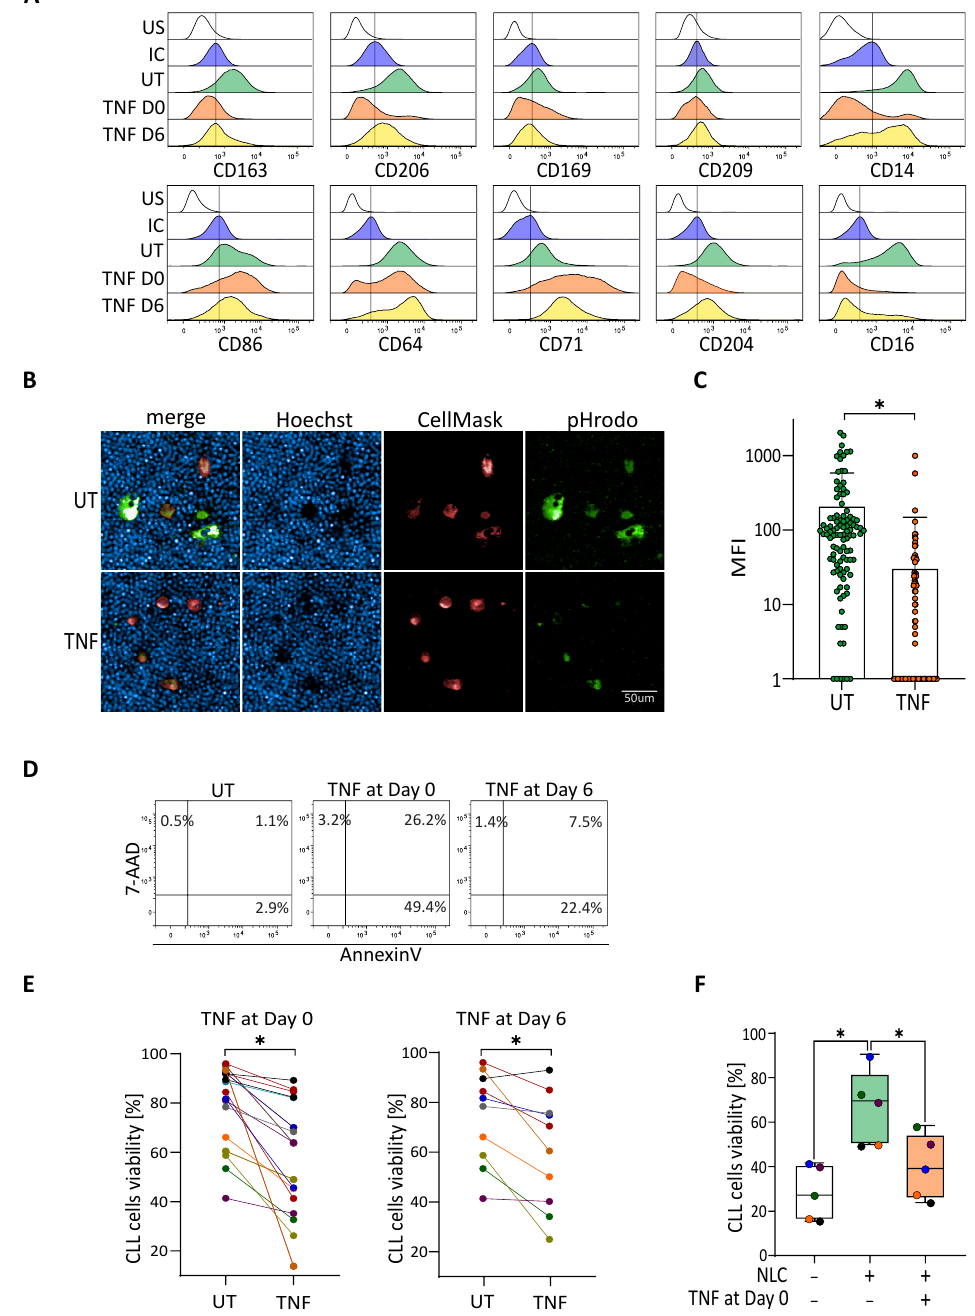
Figure 3. TNF depolarizes protective NLC, leading to a decrease of CLL cells viability. ( A ) Surface markers expressed by NLC analysed by flow cytometry at 14 days of CLL’s PBMC cultures incubated or not (UT: green) with TNF at day zero (orange) or at day six (yellow), compared to the unstained (US: white) and the isotypic (IC: blue) controls. Representative histograms from eight independent experi- ments. ( B , C ) Phagocytosis of CLL cells (blue dots) by NLC (red) is visualized. ( B ) upper: untreated; lower: TNF treated and quantified ( C ) thanks to the green pHrodo fluorescence. ( D , E )